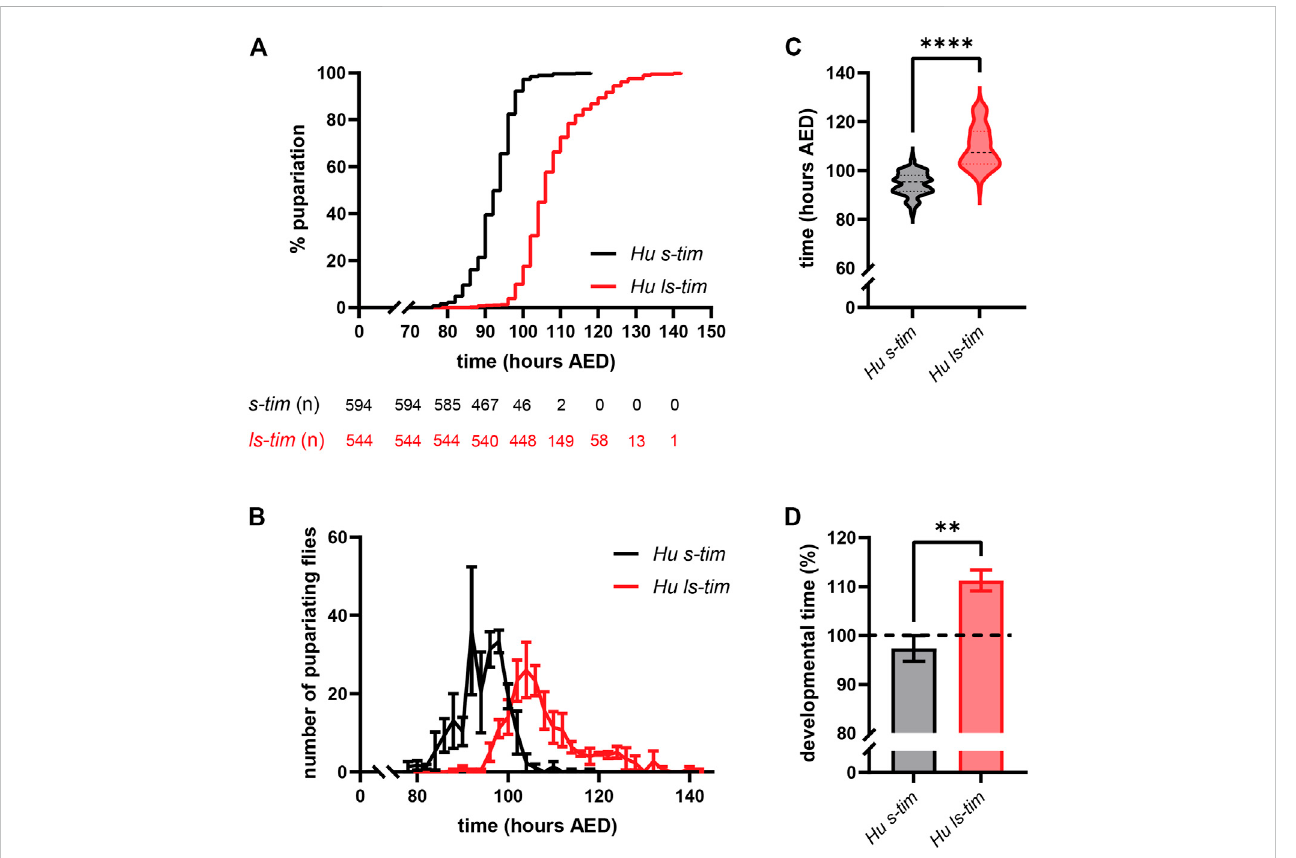
ls-tim homozygous fl ies ’ egg-to-adult development is delayed compared to that of s-tim homozygous fl ies at 25 ° C. (A) Pupariation curves of s-tim (black)and ls-tim (red)homozygouslarvae,pupariatingovertimeat25 ° C(LD12:12).Theintervalbetweenthetimeofeggdepositionandpupariationwasused to quantify developmental time. Log-rank (Mantel-Cox) test, p < 0.0001. AED: After Eggs Deposition. The number of residual, non-pupariated larvae from each genotype at different timepoints is reported below the graph. (B) Average number (±SEM) of pupariating s-tim and ls-tim homozygous larvae at 25 ° Cover-time. (C) Egg-to-adultdevelopmental time of s-tim and ls-tim homozygous fl iesat25 ° C.Statisticalanalysis ofdevelopmental time (hoursafter egg deposition, AED) was performed by Mann-Whitney U test, **** p < 0.0001. (D) % increase in the developmental time of ls-tim fl ies at 25 ° C compared to